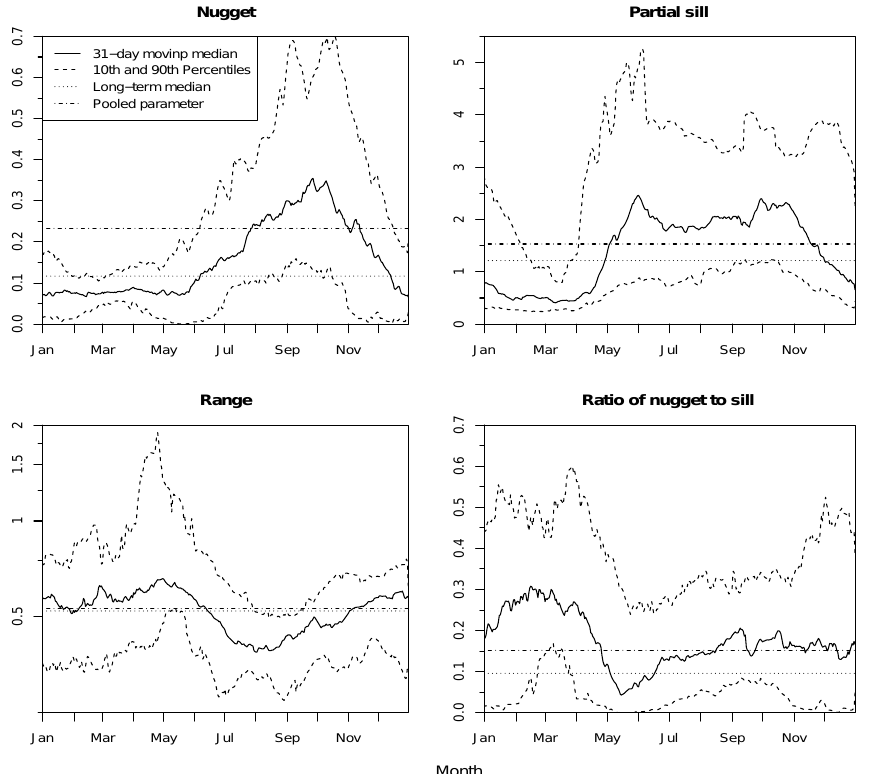
Figure 6. The 31-day moving median of daily variogram parameters and the ratio of nugget to sill. (NOTE: the vertical axis of the range is scaled by a factor of 10 6